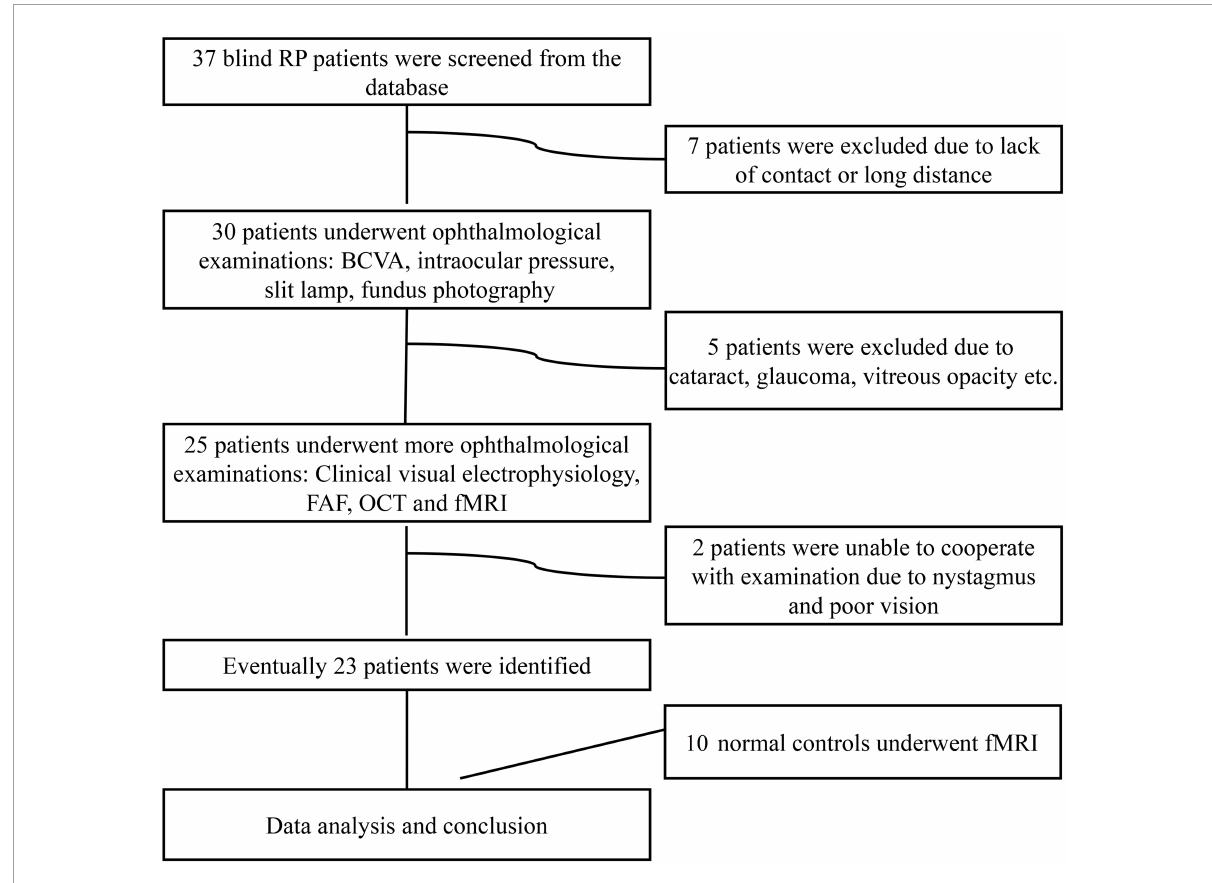
FIGURE1 Flow diagram of the patient selection process. RP, retinitis pigmentosa; BCVA, best-corrected visual acuity; FAF, fundus autofluorescence; OCT, optical coherence tomography; fMRI, functional magnetic resonance imaging.